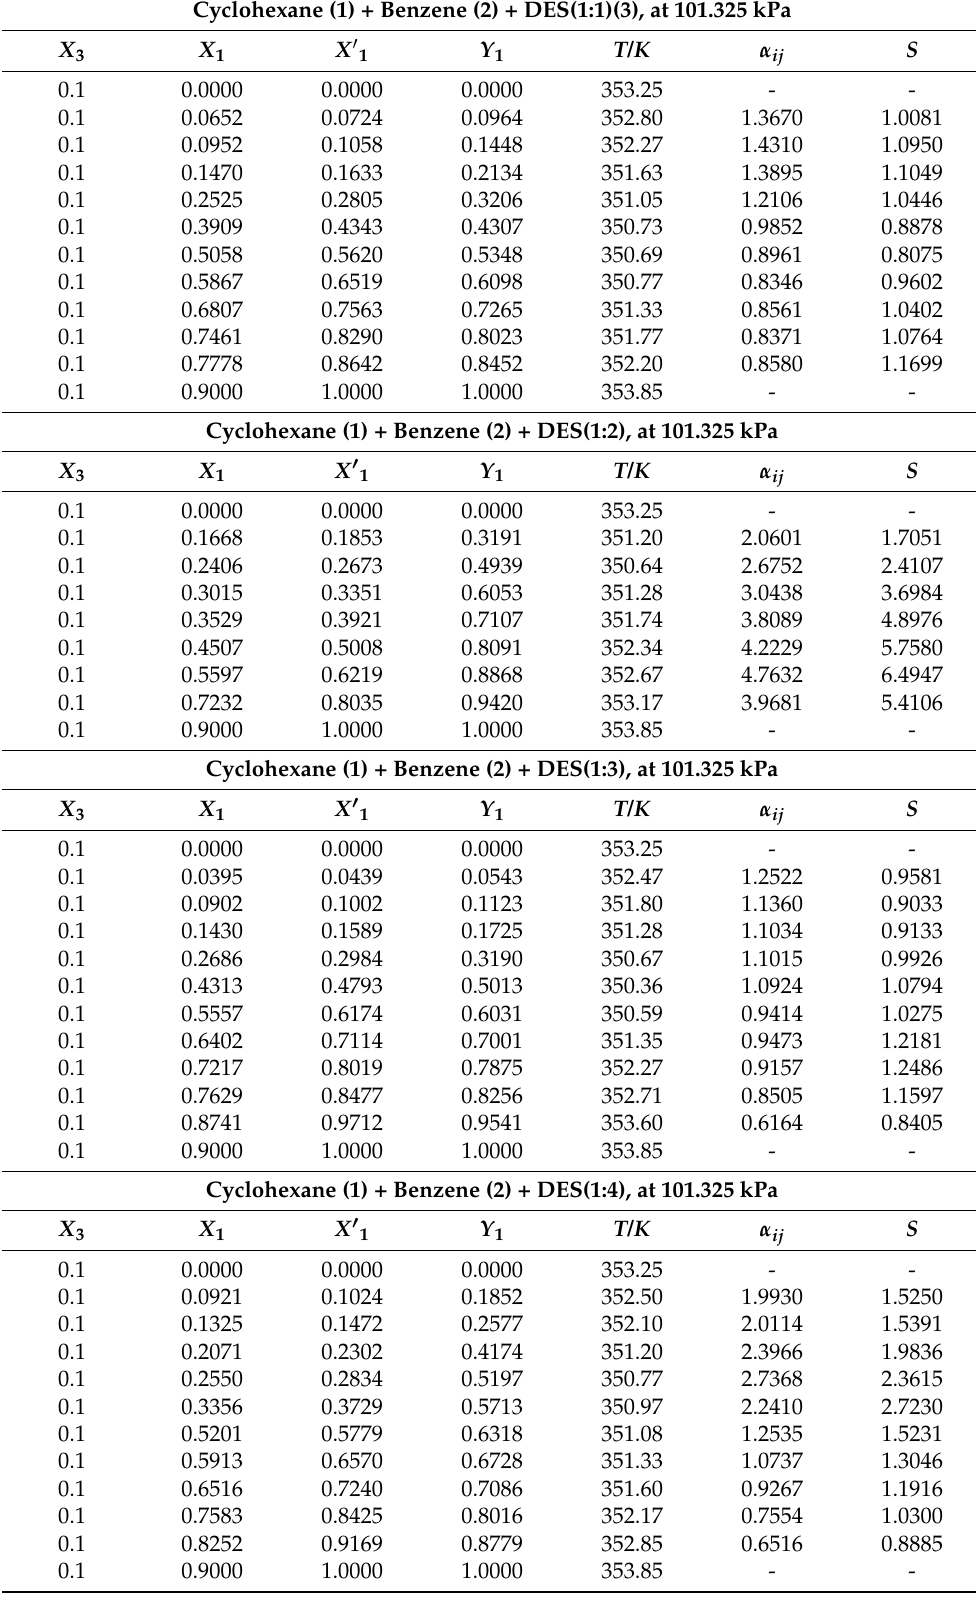
Table 6. Vapor–liquid equilibrium data of the pseudo-ternary systems (cyclohexane (1) + benzene (2) + DES